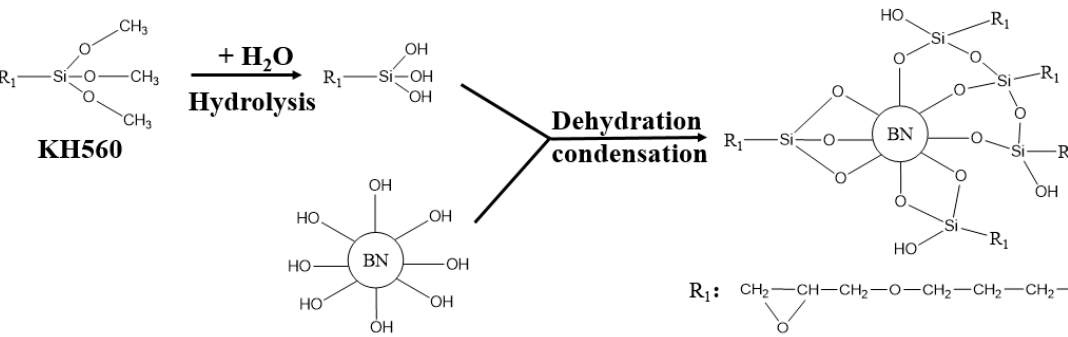
Figure 9. Schematic diagram of the reaction between SCA and BNNSs.